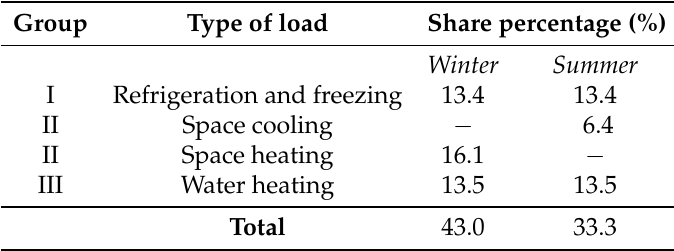
Table 2. Share of residential electricity consumption by major